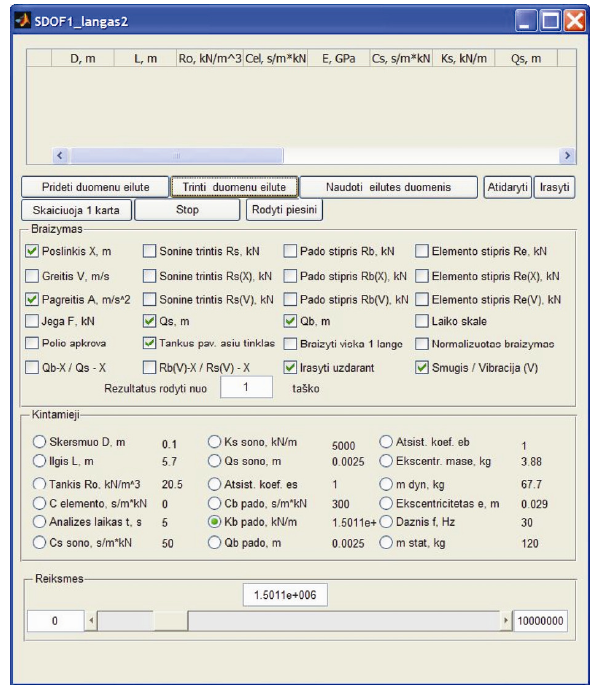
Fig. 6. Data processing interface